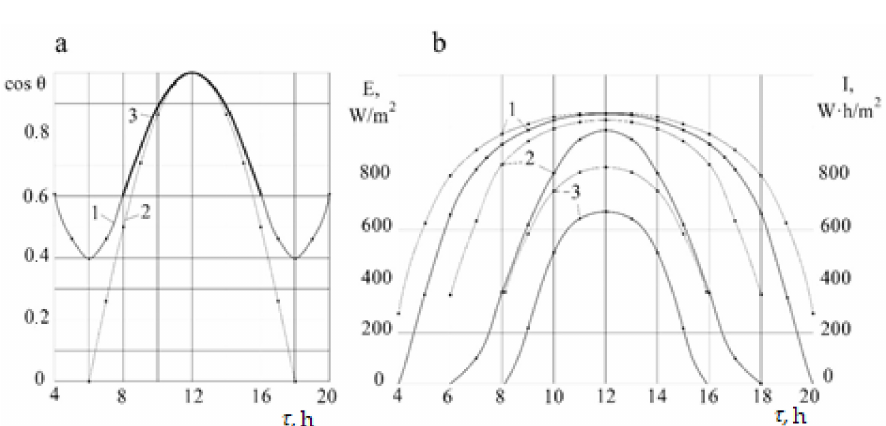
Figure 8. Orientation ( a ) and energy ( b ) efficiency of the tracking surface of horizontal-axis “east– west” tracker in the periods (own research): 1-summer solstice; 2-spring equinox; 3-winter solstice. A tracker with a horizontal axis of rotation in the direction “north–south” ( HNS axis tracker) follows a daily azimuth path of the Sun from the east to west. The current maximum of irradiation is achieved under the evident condition that the receiving surface is perpendicular to the plane, drawn across the rotation axis, the Sun normal and the surface. The appropriate scheme of irradiation and construction for measuring of the dependency of the angle of inclination and orientation efficiency of the receiving surface for the first half of a day is presented in Figure